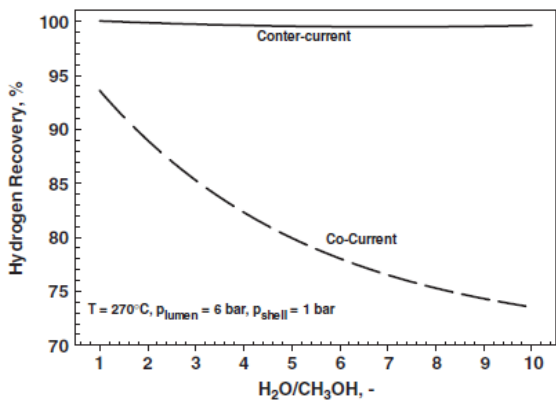
Figure 5. 1-D modelling of MSR reaction in a Pd-based MR: methanol conversion versus feed molar ratio. With permission of reprint of Elsevier from Gallucci and Basile [52]. Figure 6. 1-D modelling of MSR reaction in a Pd-based MR: hydrogen recovery versus feed molar ratio. With permission of reprint of Elsevier from Gallucci and Basile [52].